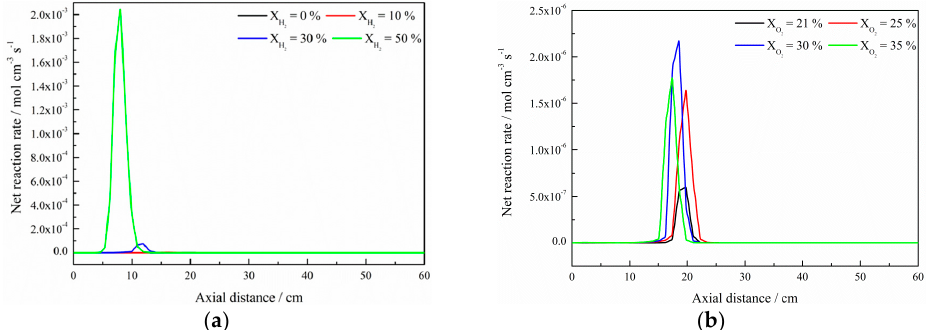
Figure 9. Net reaction rate of biogas flame along centerline at various H 2 addition ratios ( a ) and O 2 enrichment levels ( b ).